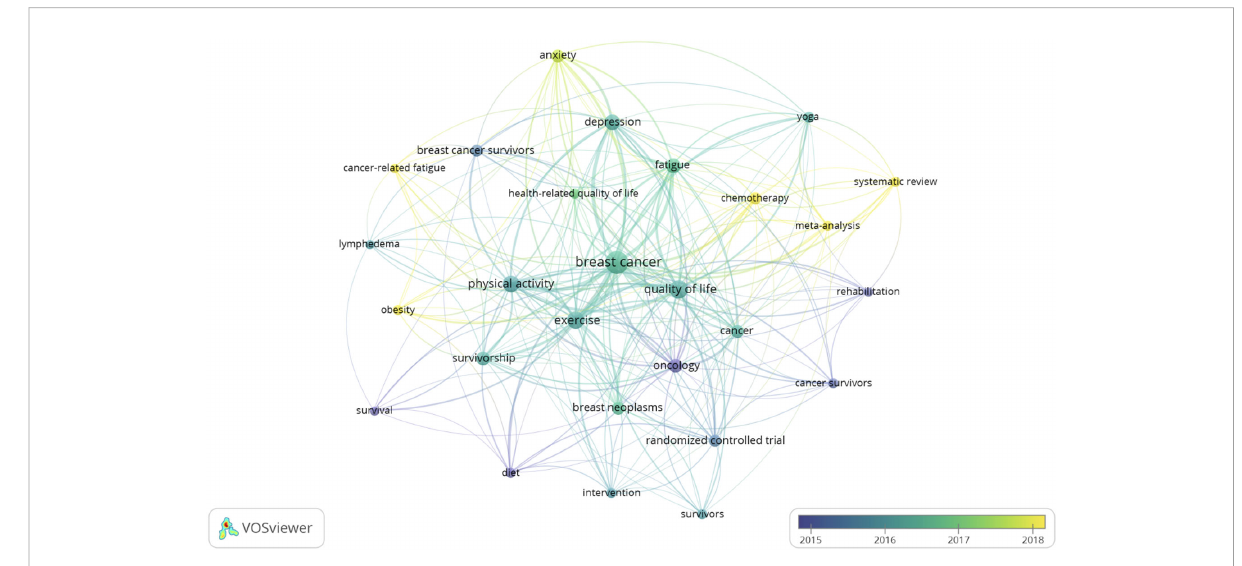
FIGURE 8 Graph with the most used author keywords: average publication